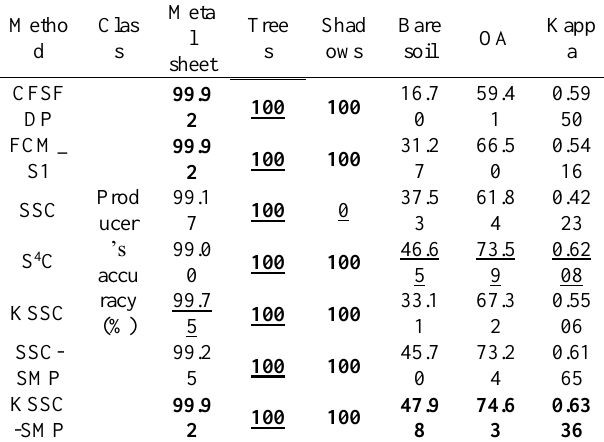
Table 2. Quantitative Evaluation of the Different clustering Algorithms with the Pavia University